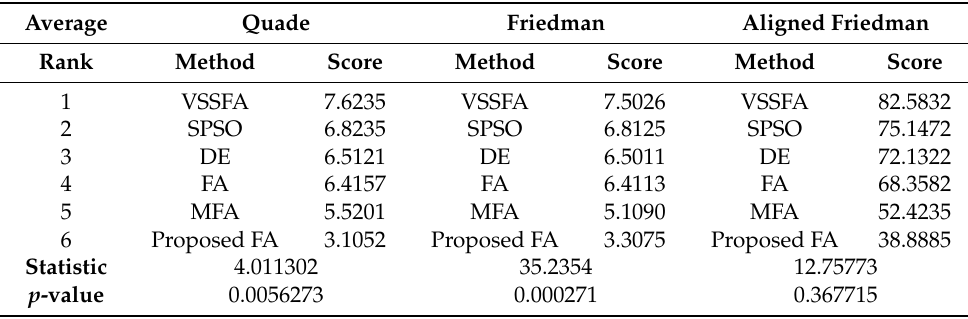
Table 7. Descending ranks of all compared methods over all problem